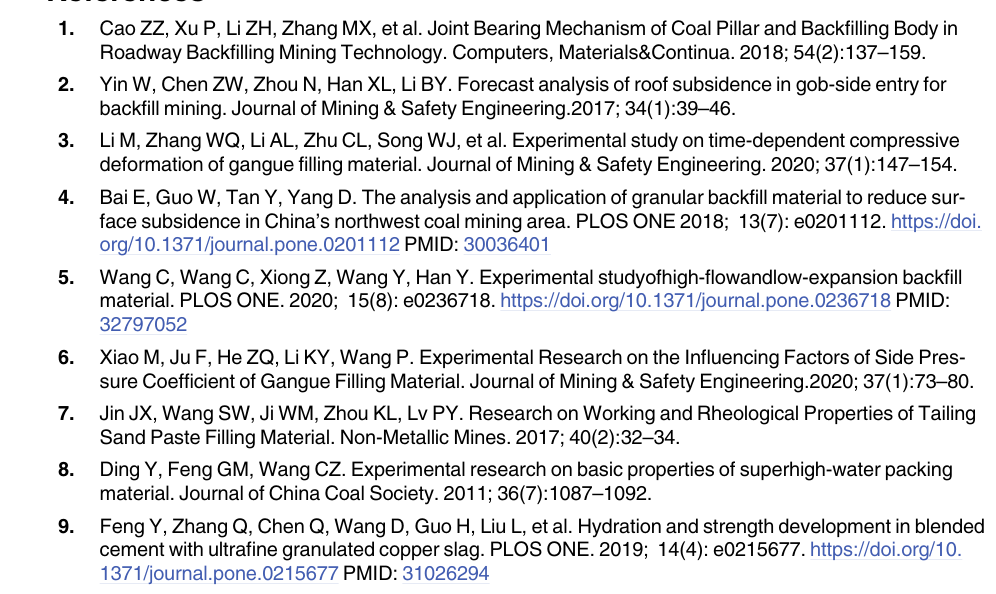
Fig 7. The fitting chart of residual strength based on H-B criterion and the improved model. (a) When the water content is 61%, (b) When the water content is 65%, (c) When the water content is 69%.